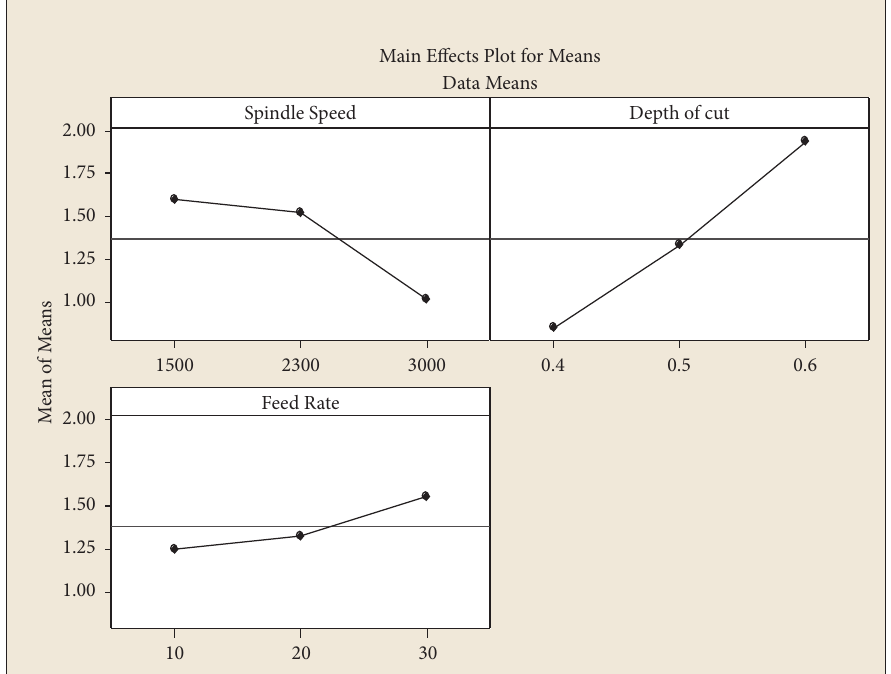
Figure 4: Means plot for R